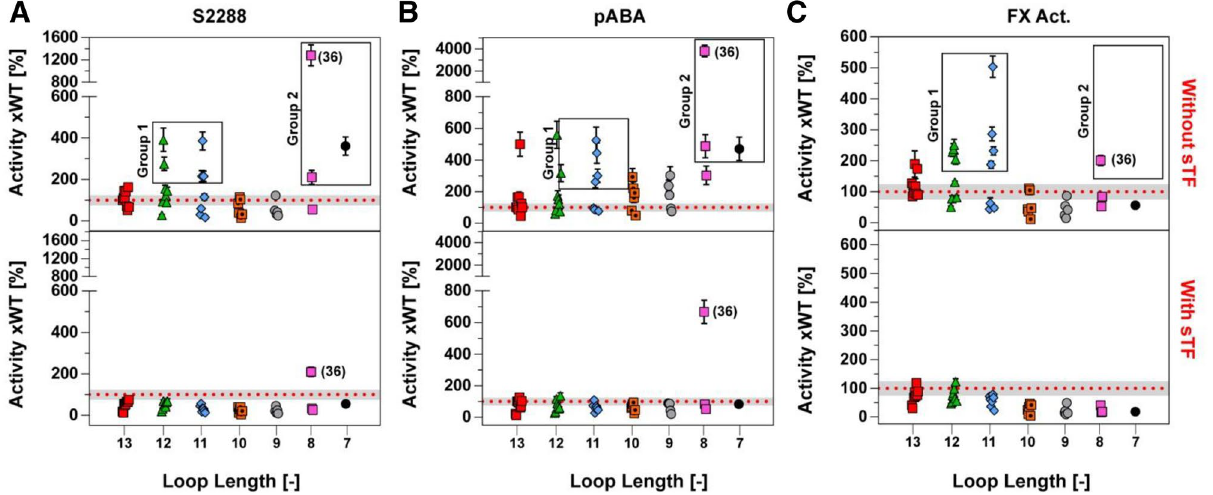
Figure 3. Functional FVIIa Data as a Function of Loop Length Normalized to FVIIa-WT in the absence of sTF (top) or presence of 3 μM sTF (bottom). ( A ) Functional data for hydrolysis of S-2288, ( B ) inhibition of FVIIa variants by pABA and ( C ) Activation of factor X. Group 1 consist of variants no. 12–14 and 20–22 while group 2 contains of variants no. 36, 37 and 39. Data is shown as the mean (n = 2) with high-low error bars for S-2288 and pABA, with mean ± SD (n = 4) for FX activation. The grey shaded area represents one standard deviation for FVIIa-WT around the mean (n = 6) from experiments conducted on different days and different plate positions. Loop length is the remaining number of residues in the 170-loop s for a give variant after a deletion, starting from the wild-type length of